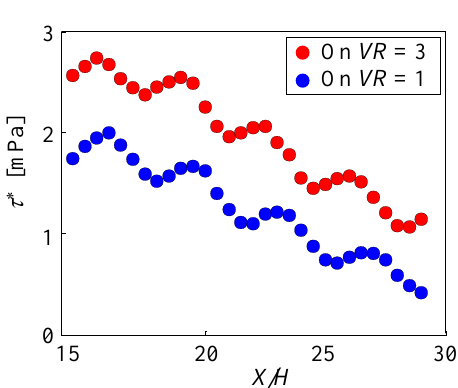
Fig. 6 Vortical strength of transverse vortex   ) in the streamwise direction in case 2 ( VR = 1 and 3) at Re =300 and F